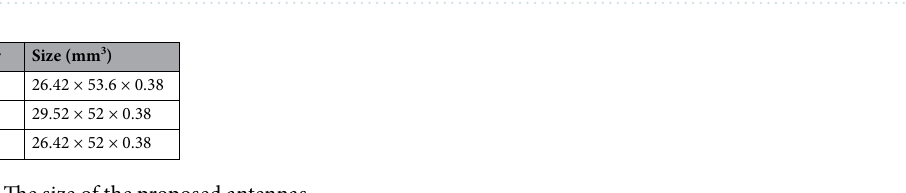
Table 1. The size of the proposed